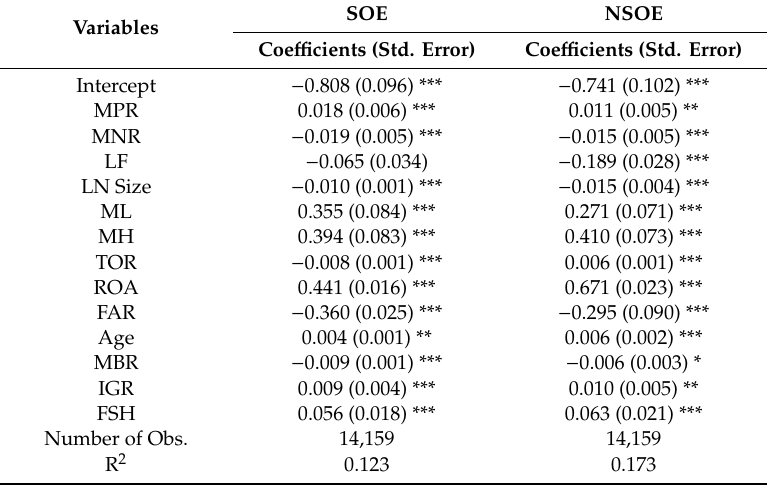
Table 5. Estimated regression